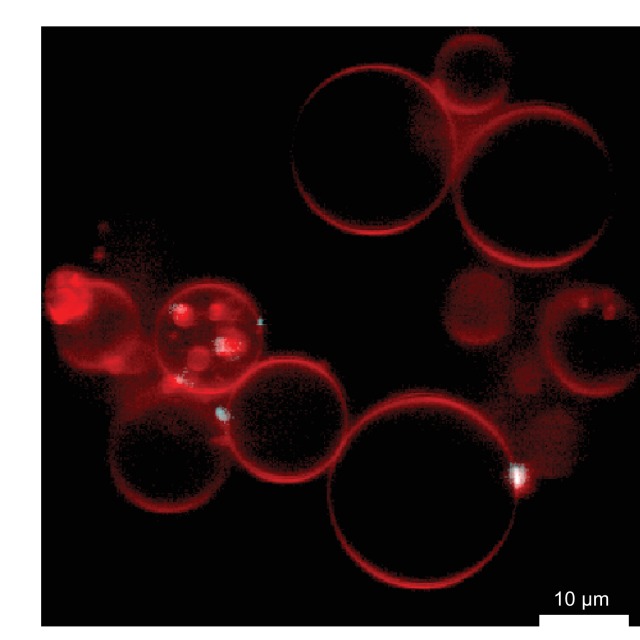
Gag binding to GUVs under conditions of the SHAPE analysis.Gag and GUVs were prepared as for SHAPE analysis. In the final step DMSO without SHAPE reagent was added and GUVs were imaged by confocal microscopy. A representative field of view is shown.